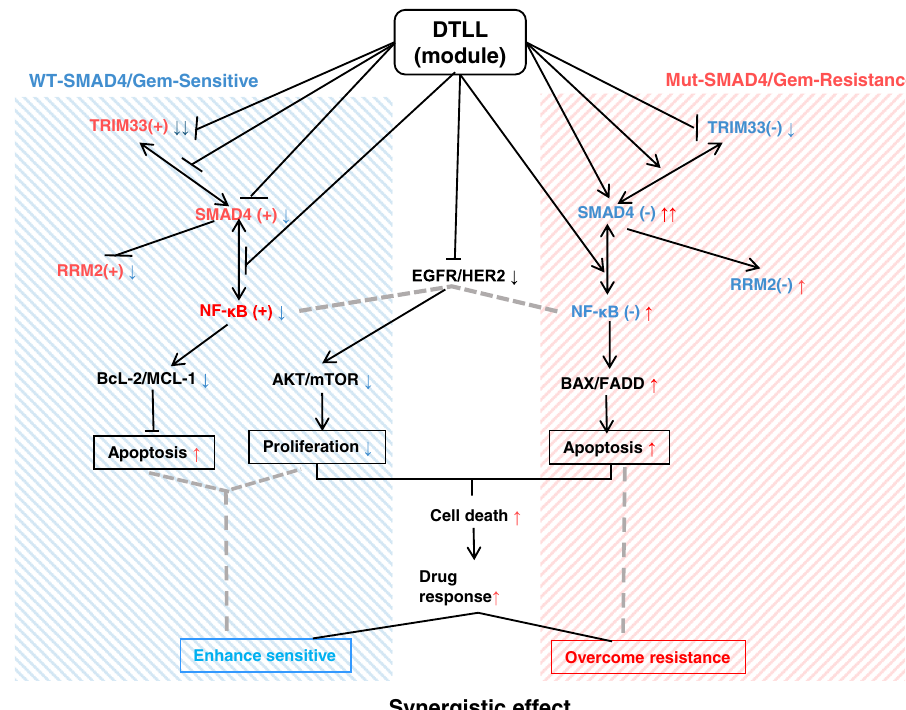
Fig.9 |SchematicillustrationmodeloftheDTLLactionmechanism alongwith mutant and wild-type SMAD4 in PDAC cells. There were different action mechanisms of mutant and wild-type SMAD4 on the PDAC drug response with/ without DTLL induction. The SMAD4 genetic status of PDAC is responsible for SMAD4 protein levels which determine different cellular susceptibilities. DTLL seems to act as a module of the SMAD4 driver that normalizes its function as a tumor suppressor according to SMAD4 level and genetic status in PDAC, and then adjusts NF- κ B, TRIM33, gemcitabine-metabolic enzymes (such as RRM2) and pro- teomic pro fi les of PDAC cells, which explains the synergistic effect on tumor growthofDTLLincombinationwithgemcitabine.Speci fi cally,DTLLcontributesto decreases mainly in AKT/mTOR signaling and anti-apoptotic proteins (Bcl-2 and MCL1) by impaired NF- κ B function in WT-SMAD4/GEM-sensitive PDAC cells.